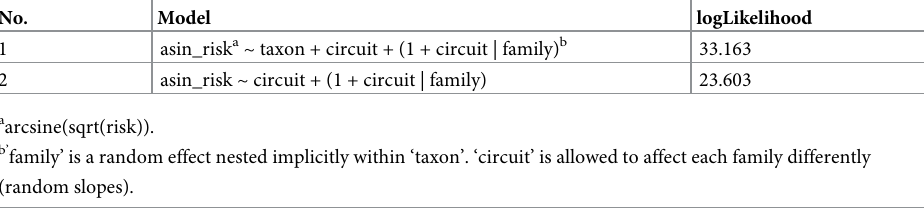
Table 2. Linear mixed models of predation risk per rearing